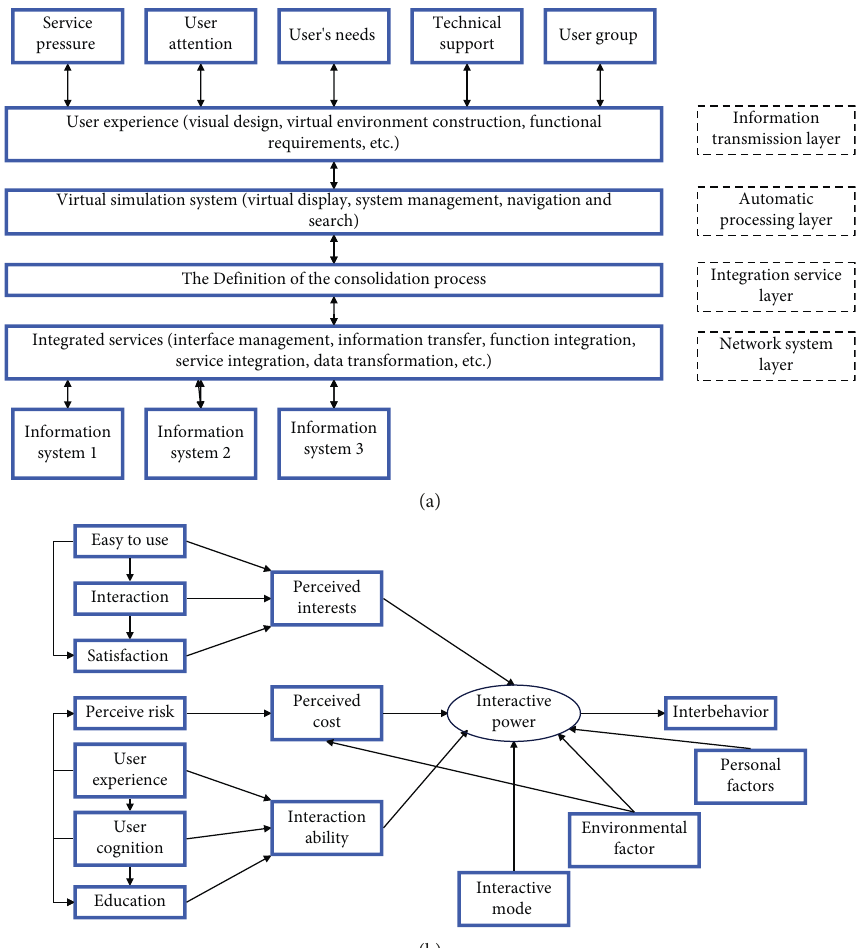
Figure 8: Virtual reality product design model. (a) Virtual simulation resource integration model. (b) Integrated model for virtual simulation design system evaluation.